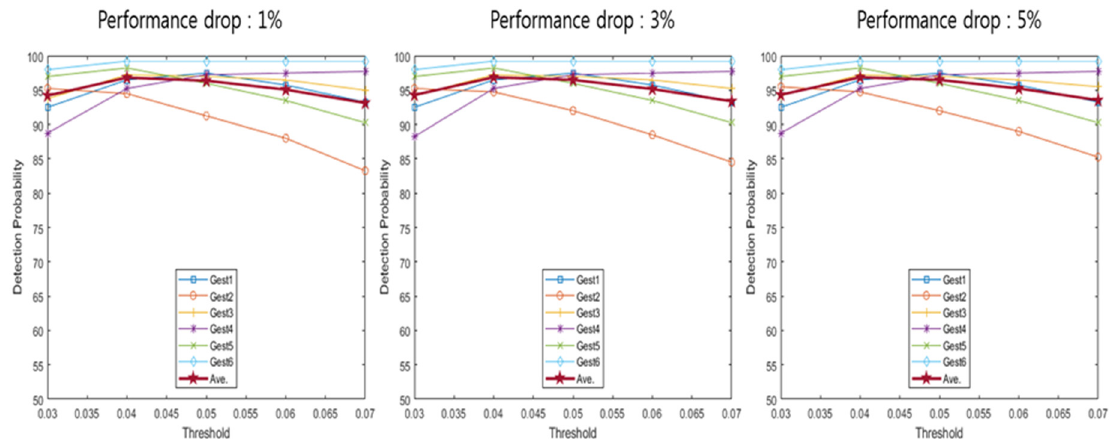
Figure 13. Detection probability of proposed method 2 (window 2). Table 2. Averaged detection probabilities of conventional methods [20]. Table 1. Detection range of each hand gesture.